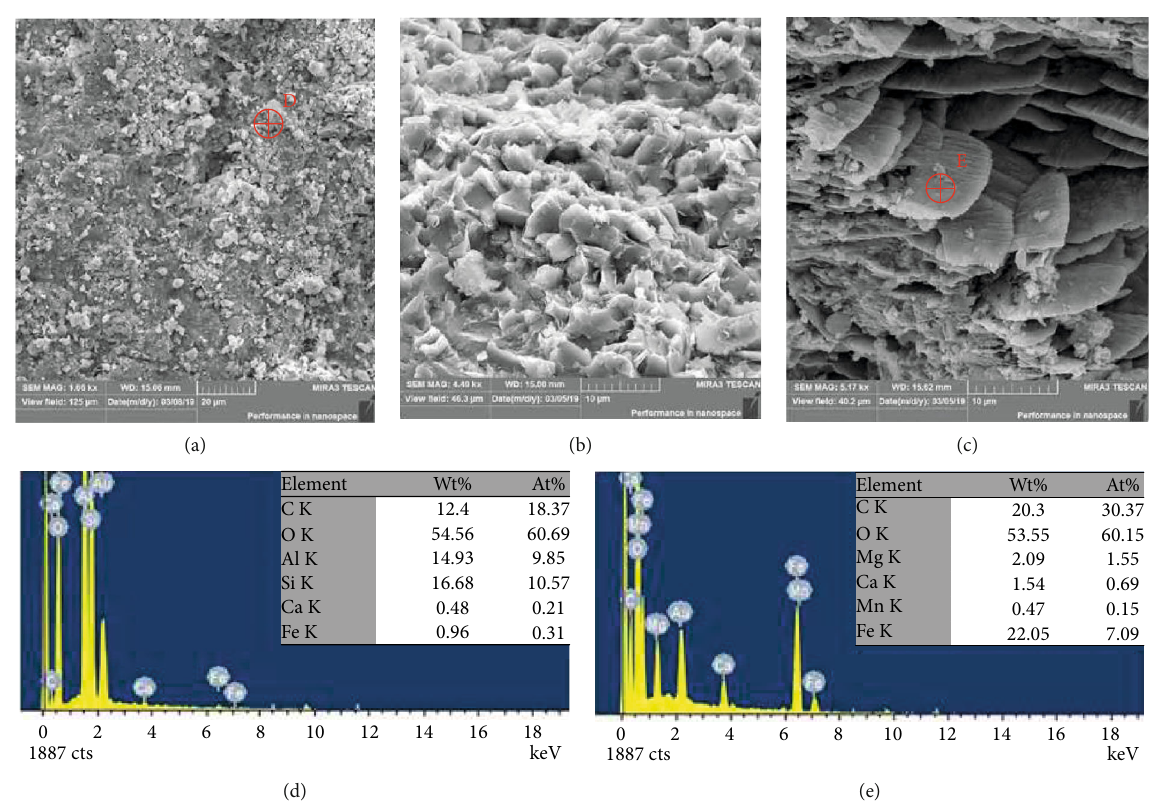
Figure 9: SEM images of samples TS2 (a) and TS6 (b, c) showing the EDS measurement points. (d, e) EDS patterns at the spots noted in panels (a) and